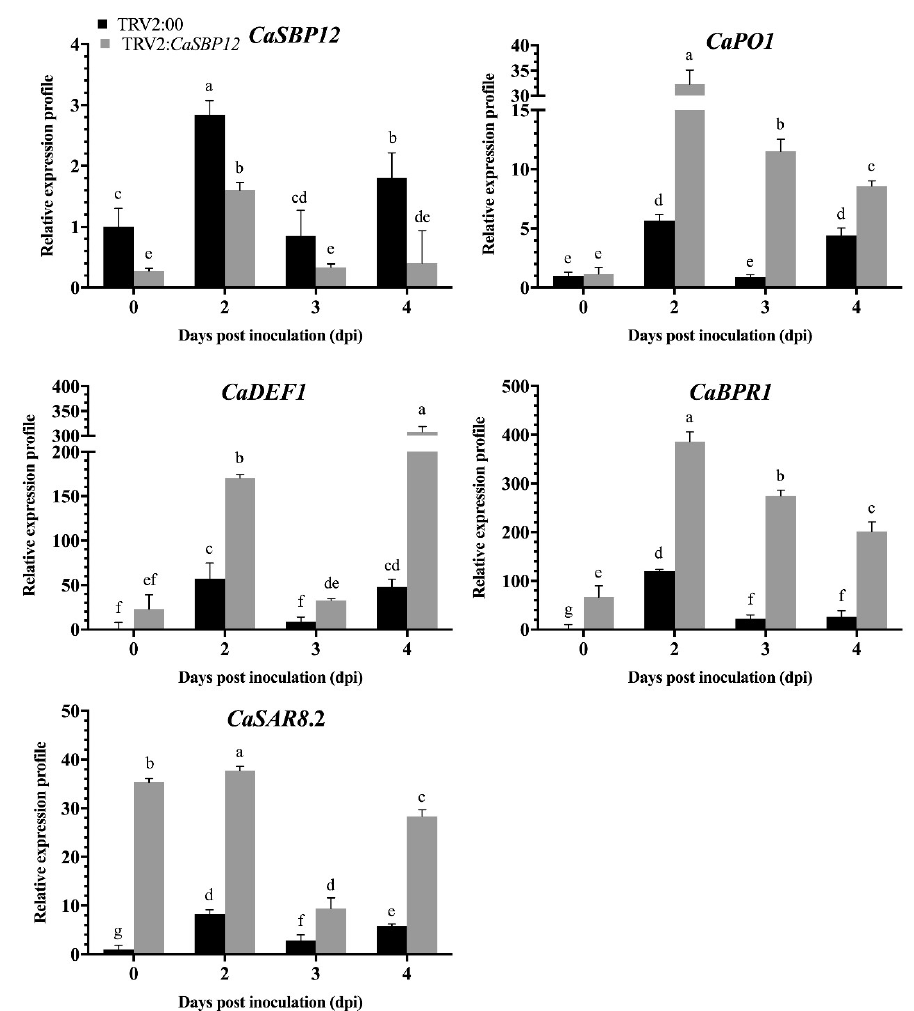
Figure 5. The expression of CaSBP12 and defense related genes after inoculation with the PC strain of P. capsici in silenced and control plants. After measuring the silencing efficiency of the CaSBP12 gene, 5 mL of 1 × 10 5 cfu/mL zoospore of P. capsici were used to inoculate the silenced and control plants, respectively, using the root-drench method, and then roots of silenced and control plants were collected at 0, 2, 3, and 4 d for the detection of defense related genes. The means were analyzed using the least significant difference (LSD). Bars with different lower-case letters indicate significant difference at p ≤ 0.05. Mean values and SEs for three replicates are shown.